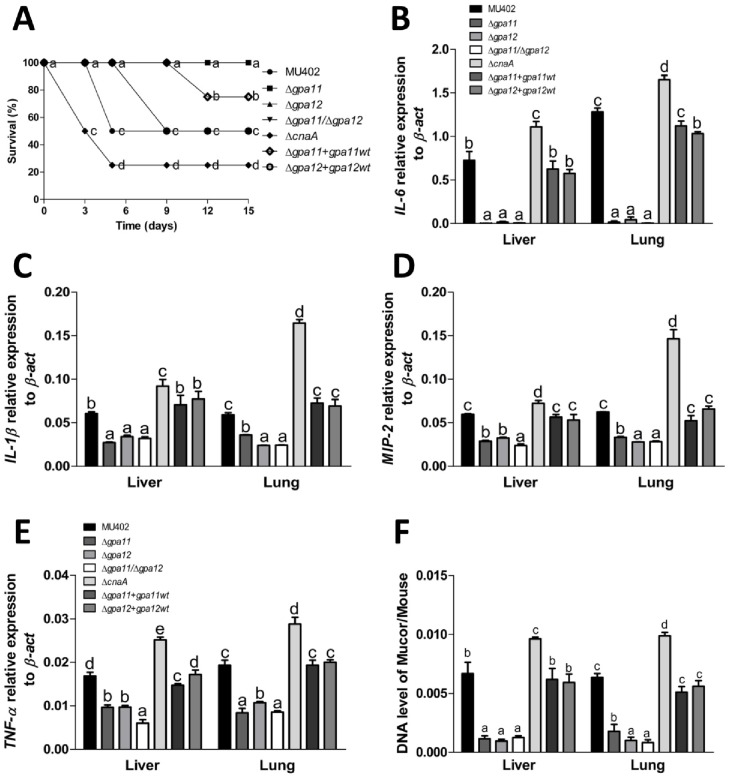
Role of gpa11 and gpa12 in the virulence of M. circinelloides.A) Survival of diabetic mice infected intraperitoneally with 2 × 107 sporangiospores from different M. circinelloides strains recorded each day post-injection. N = 8, two independent experiments. Relative expression of inflammation markers B)
IL-6, C)
IL-1β, D)
MIP-2, E)
TNF-α used to monitor tissue damage in the liver and lung of mice infected with spores from the different M. circinelloides strains (N = 4). F) Fungal burden, determined by qPCR, from the liver and lung of infected mice. Three independent experiments were performed for each condition. Statistically significant differences are indicated by different letters (ANOVA and Fisher’s tests; p ≤ 0.05).